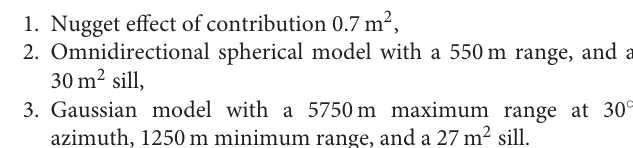
domain. This assumes the bedrock and Till unit elevations are already